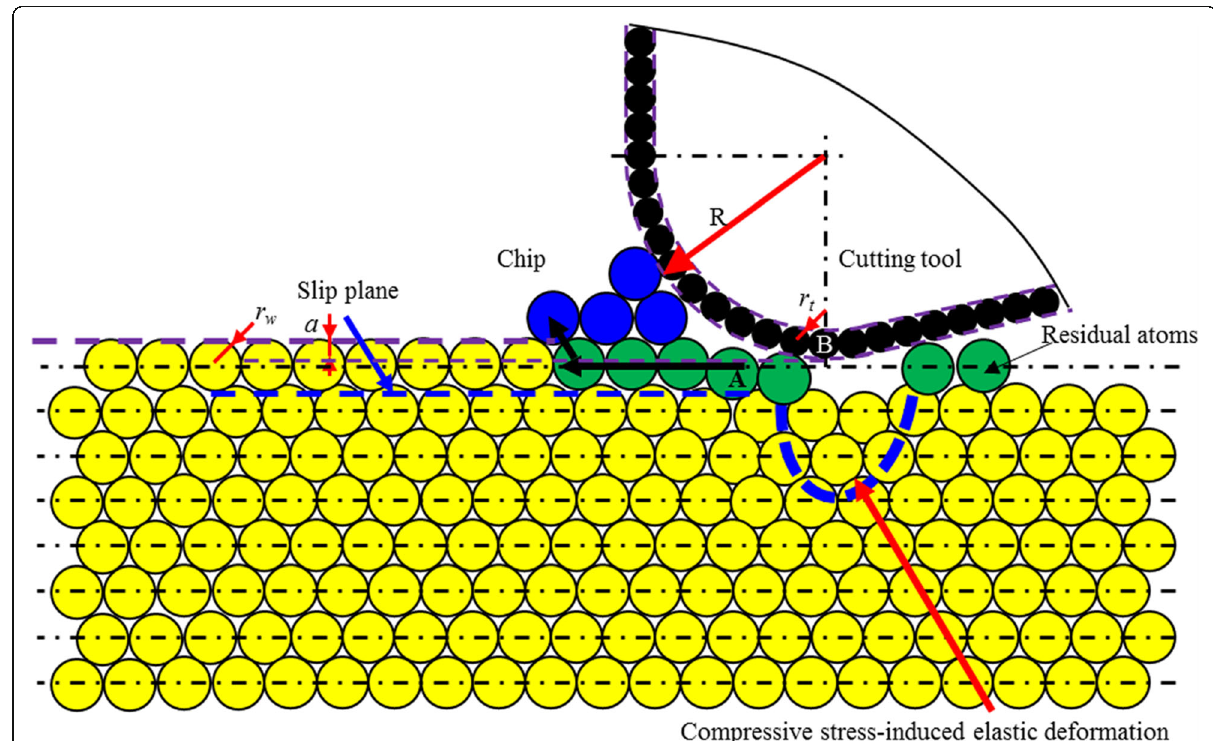
Fig. 16 Schematic illustration of cutting-based single atomic layer removal at a/r w larger than C 1 and smaller than C